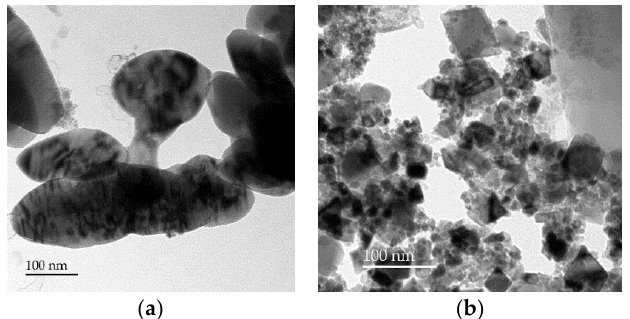
Figure 4. Observation of CaCO 3 coated microspheres with Transmission Electron Microscopy (TEM) 400×: ( a ) Agglomeration of CaCO 3 microspheres; ( b ) Cubic CaCO 3 coated particles.